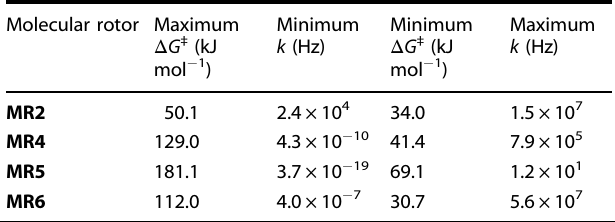
Fig. 2 Load-modulated free energy barrier for different molecular rotors. a Illustration of directional mechanical load on MR2 and its reversible controllability on free energy barrier of thiophenyl group. The dipole moment is denoted with pair of positive and negative signs. Applying load enables smaller free energy barrier and faster fl ip of thiophenyl group. Combination of both thiophenyl groups creates a “ stop- go ” system with polar and non-polar bi-states in MR2 . b Free energy barrier for MR2 , MR4 , MR5 , and MR6 from polar state to non-polar state under directional mechanical load. Table 1. Maximum and minimum free energy barrier Δ G ‡ and rotational speeds k at 300 K of molecular rotors under mechanical load from points in Fig.